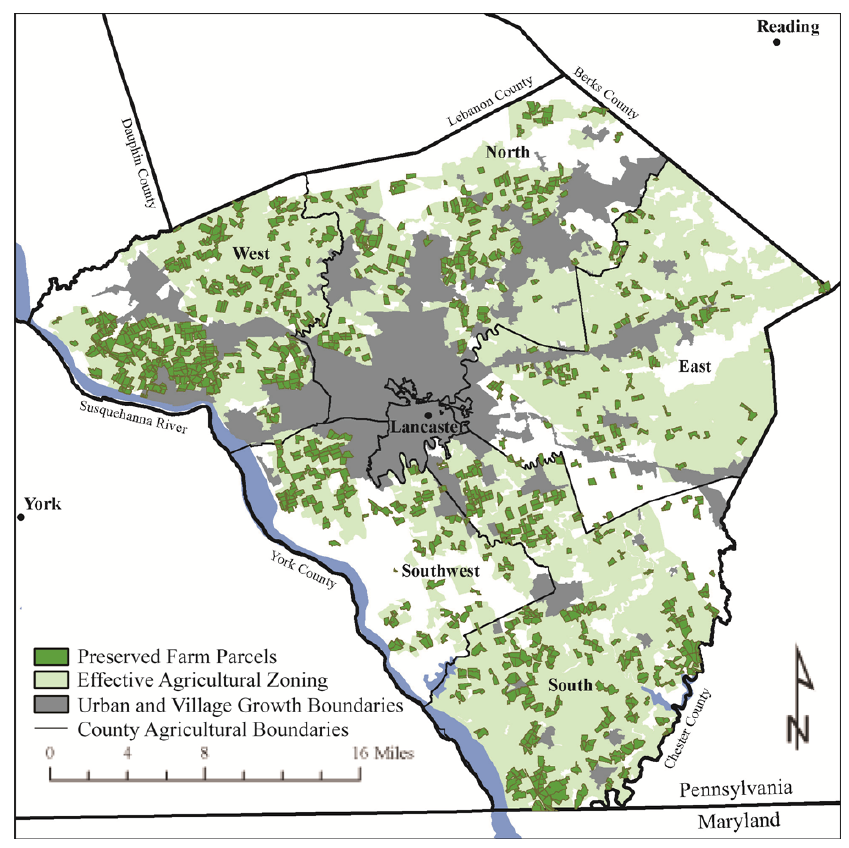
Figure courtesy of Christina Arlt; used by